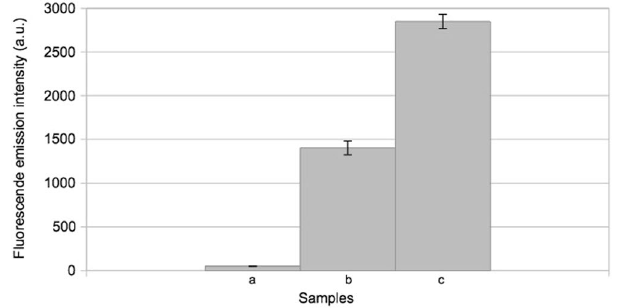
Figure 6. Fluorescence emission intensity (expressed in arbitrary units, a.u.) in 40 mM HEPES pH 7.4, 100 mM KCl, 1 mM MgCl 2 . From left to right: ( a ) background; ( b ) 0.5 μ M Broccoli aptamer; 1 μ M Broccoli aptamer (mean ± standard deviation, n =